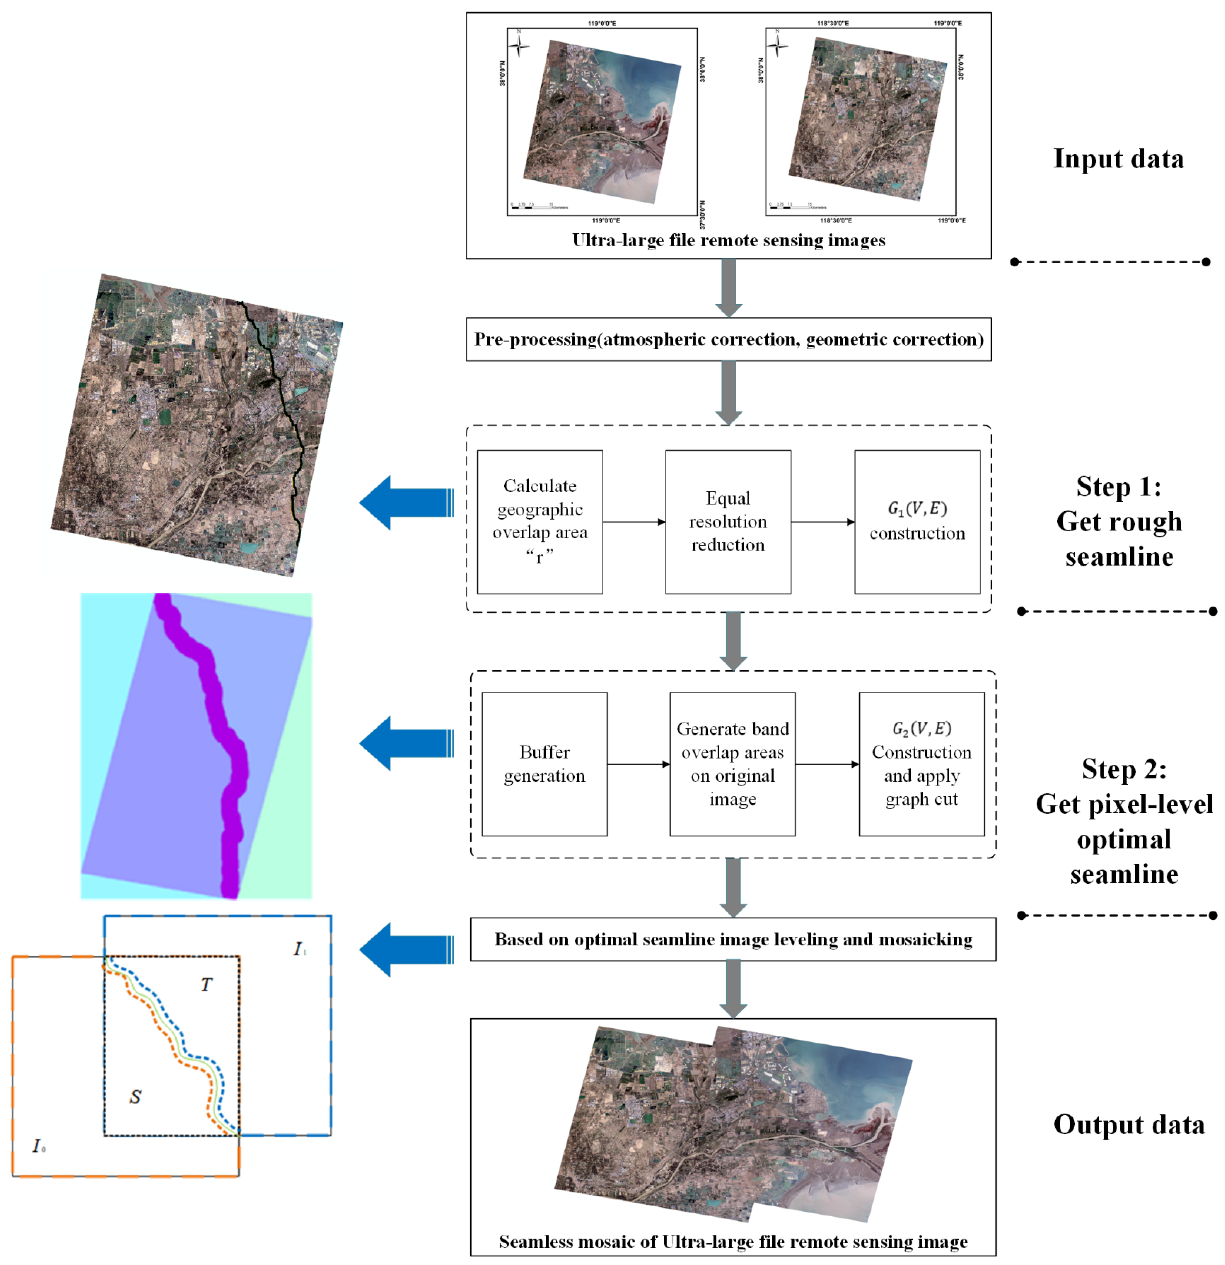
Figure 1. Flowchart of the proposed high-performance mosaic optimization algorithm for very large remote sensing images.